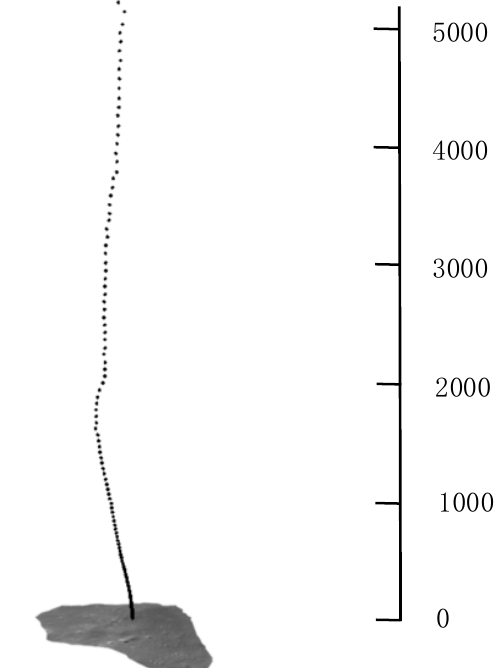
Figure 6. The recovered trajectory of Chang’e-4